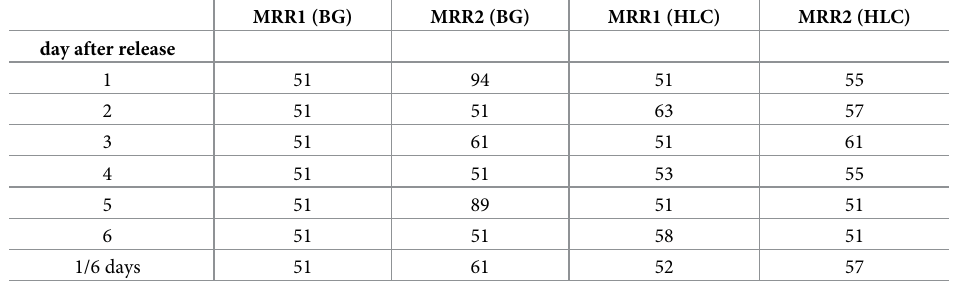
Table 4. Mean distance travelled (in meters) of recaptured Aedes albopictus sterile males in two mark-release- recapture experiments on Procida